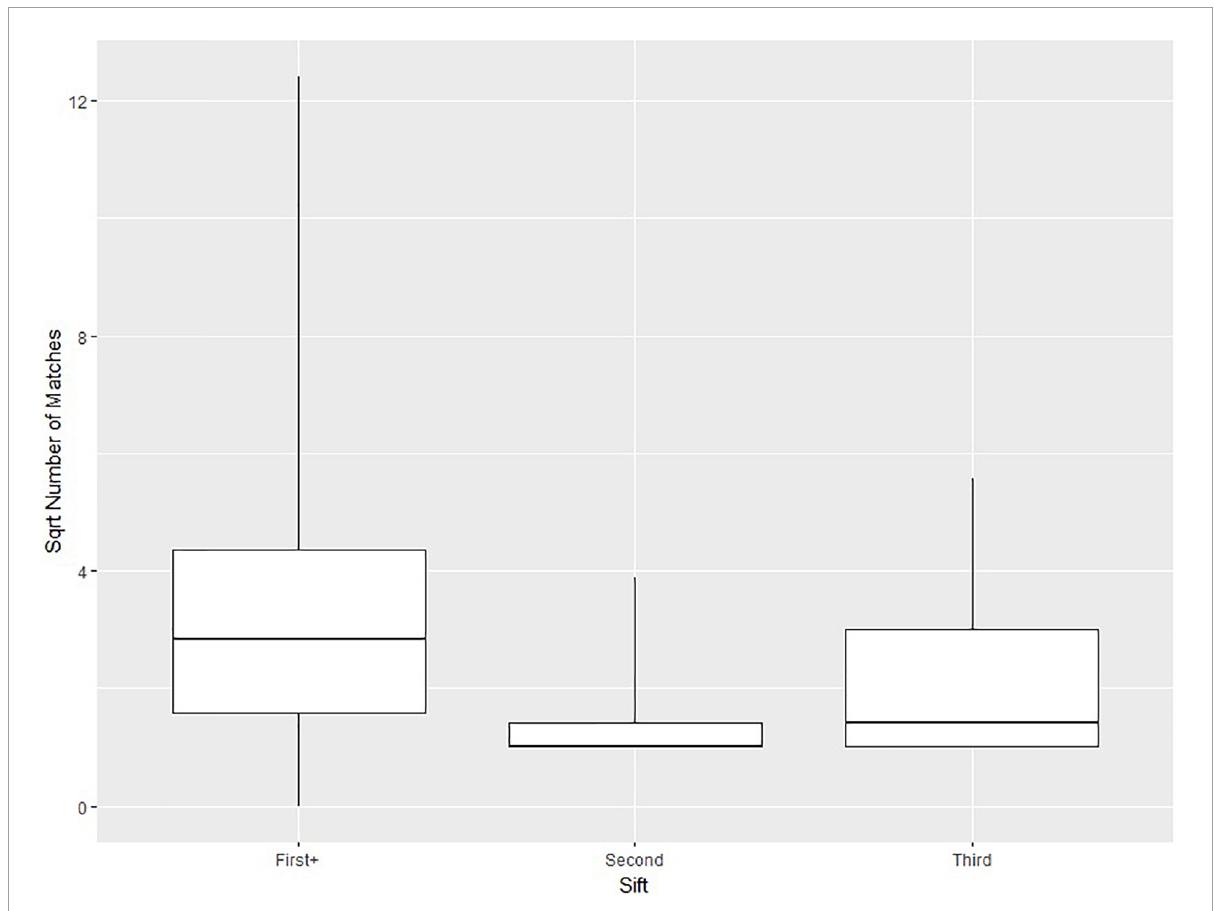
FIGURE7 Boxplots indicating the 0th, 25th, 50th, 75th, and 100th percentiles of the square root of the number of matches across 3 of the sifts: “ First +”, “ Second ”, and “ Third ”.